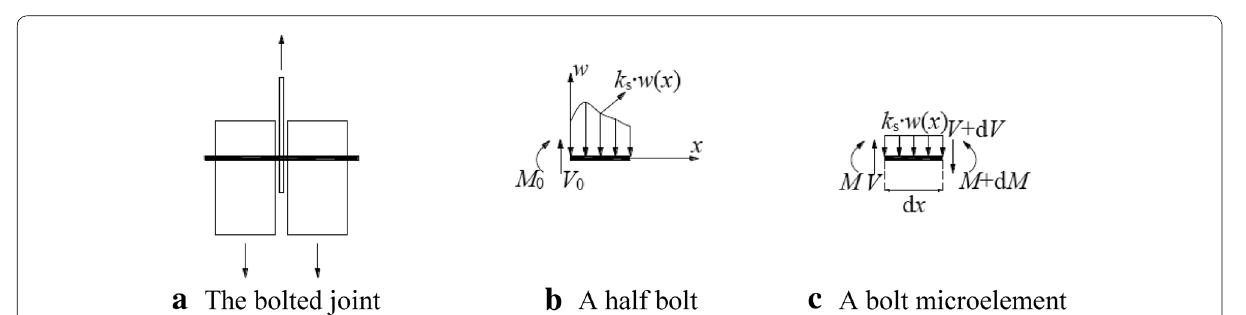
Fig. 11 Free body diagrams of a